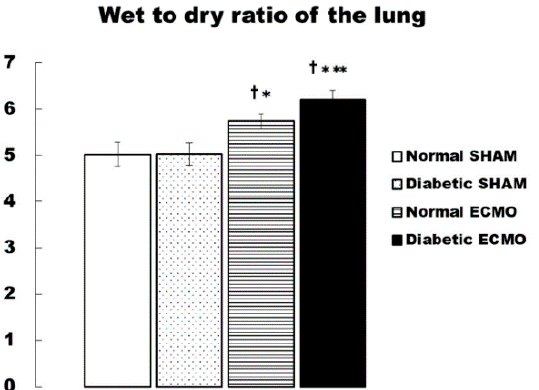
Figure 4. Wet-to-dry (W/D) ratio of the left lung at the end of cardiopulmonary bypass. † p < 0.05 versus normal SHAM group at the same time, * p < 0.05 versus diabetic SHAM group at the same time, ** p < 0.05 versus normal ECMO group at the same.